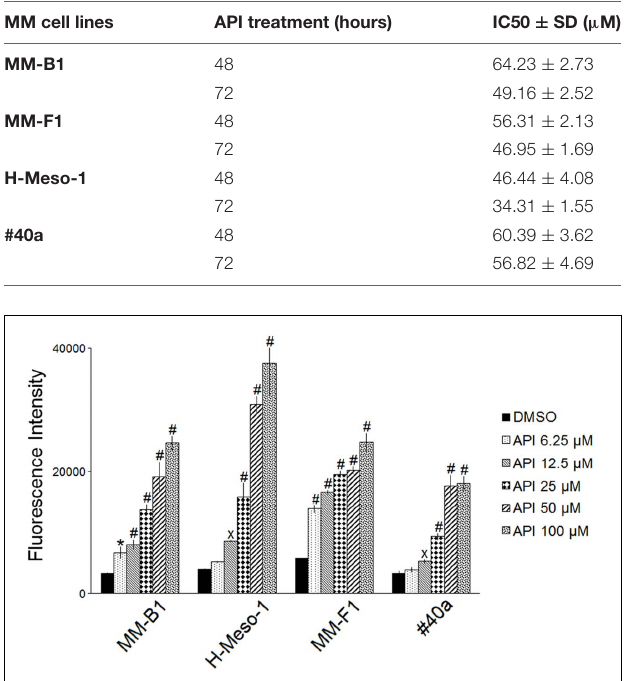
TABLE 1 | Apigenin (API) concentrations required for 50% inhibition of malignant mesothelioma (MM) cell lines growth (IC50).